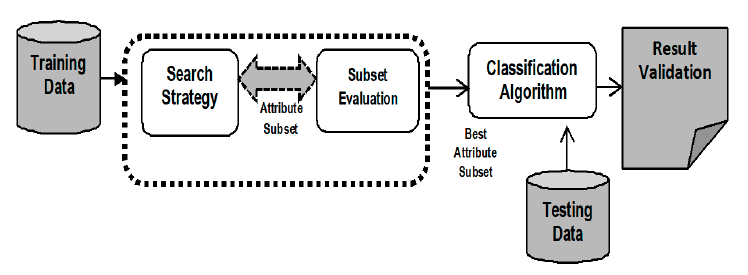
Figure 3. Filter Method for Attribute Selection.